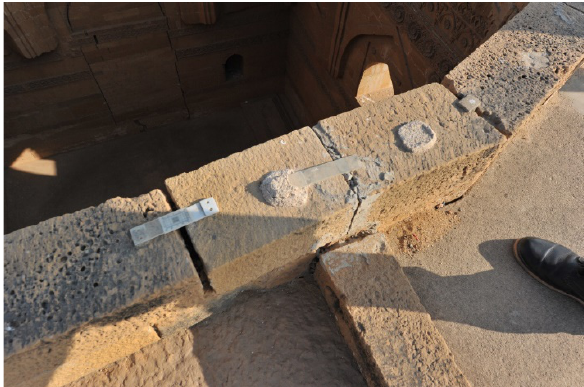
Figure 2. Old plaster and glass crack monitors were